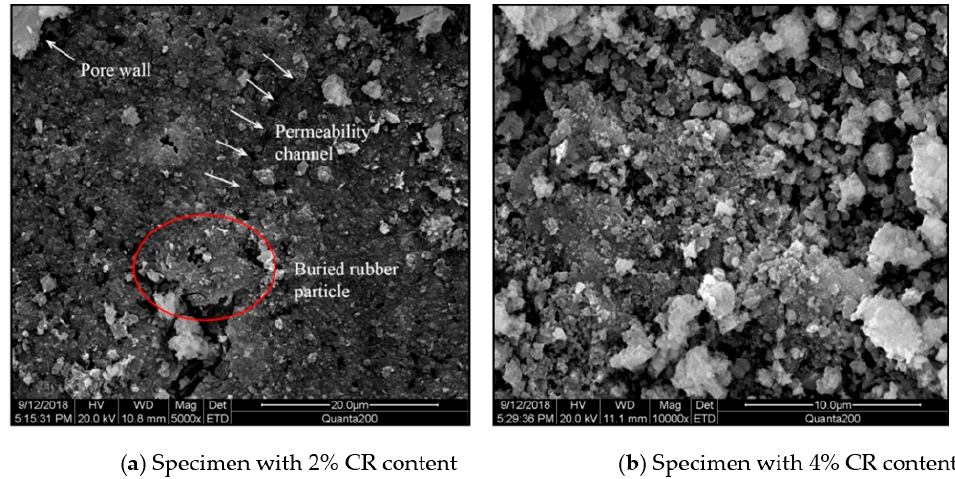
Figure 7. SEM images of foamed concrete incorporated with CR [81]. Rubber particles size also has great influence on the water absorption of concrete. Yil- maz and Degirmenci [82] incorporated 20% of three types of rubber particles with different particle sizes (0–0.25, 0.25–0.5, and 0.5–1.0 mm) into concrete, and the water absorption was 30%, 26%, and 24%. As the rubber particle size increased, the water absorption decreased slightly. Li et al. [77] found the same phenomenon. RC with fine RA needs substantial water to achieve the same workability as the control group; rubber particles with large particle size are easy to mix because the surface is smooth and spherical [71]. However, an excessively large particle size has a negative effect. Sukontasukkul and Tiamlom [76] reported that when CR No.6 (0.5–3.35 mm) was incorporated into concrete; as the blending amount increased, the water absorption increased. By contrast, CR No.26 (0–0.5 mm) incorporated into concrete reduced water absorption. The rubber surface formed bubbles due to the non-polar rubber particles surface, and the internal porosity of RC increased. The volume of the captured bubble was larger, and the RA size increased, as shown in Figure 8. Although the surface of CR No.26 also formed bubbles, the volume of the bubbles was small. These small bubbles formed a separate closed space and did not act as a water seepage channel. Moreover, CR No.26 had a good filling effect, and can effectively fill the pores and reduce the porosity in RC. Similar results were obtained with rubber powder (0.1–1 mm) as a replacement for partial cement in concrete